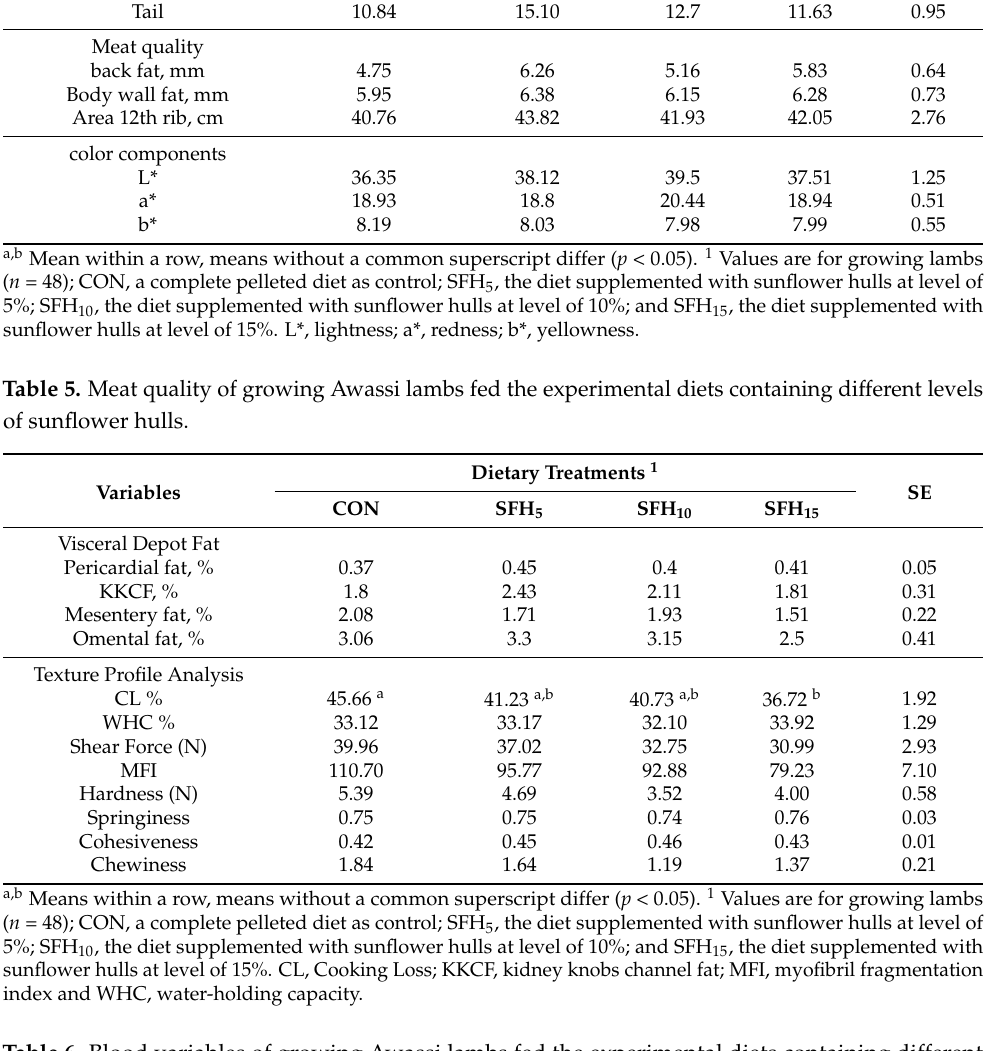
Table 6. Blood variables of growing Awassi lambs fed the experimental diets containing different levels of sunflower